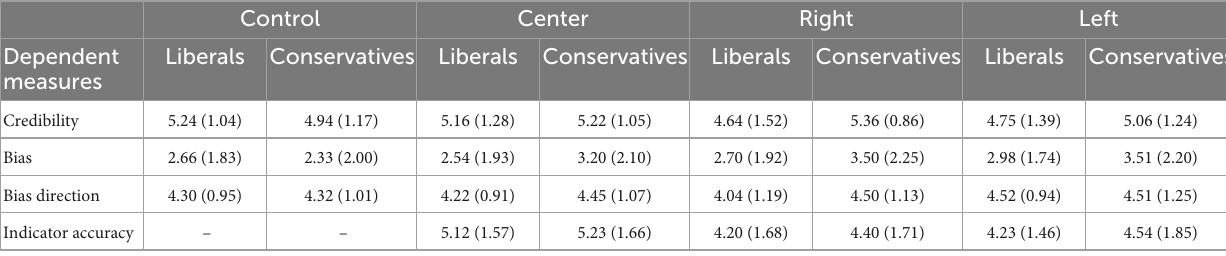
TABLE 1 Study 1 means and standard deviations across bias indicator conditions and participant political ideology. Control Center Right